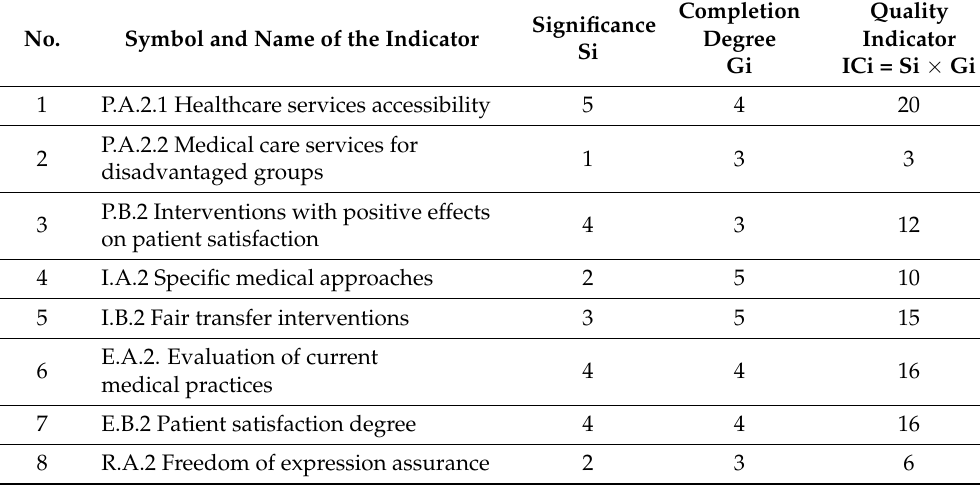
Table 19. Self-assessment tool for human rights